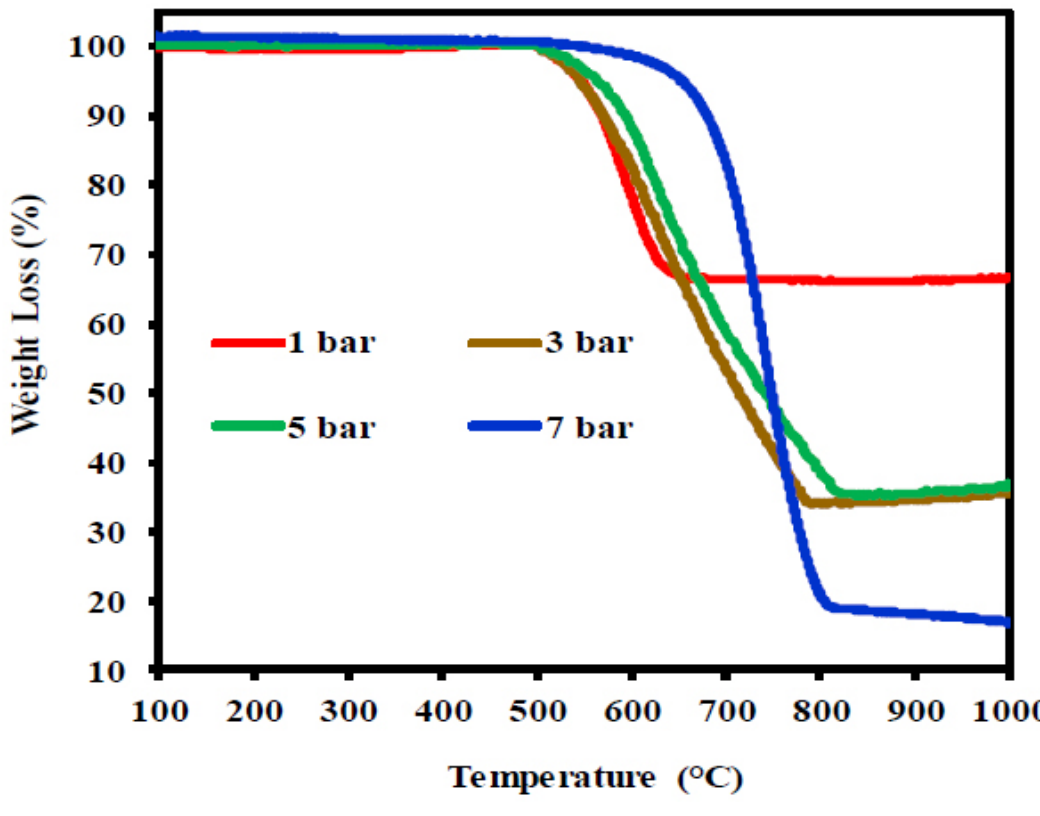
Figure 10. TGA patterns for catalyst, calcined at 725 ◦ C, after 8 h reaction time in DRM, operated at 700 ◦ C for pressure (1, 3, 5, 7 bar).; GHSV 84,000 (mL / (g